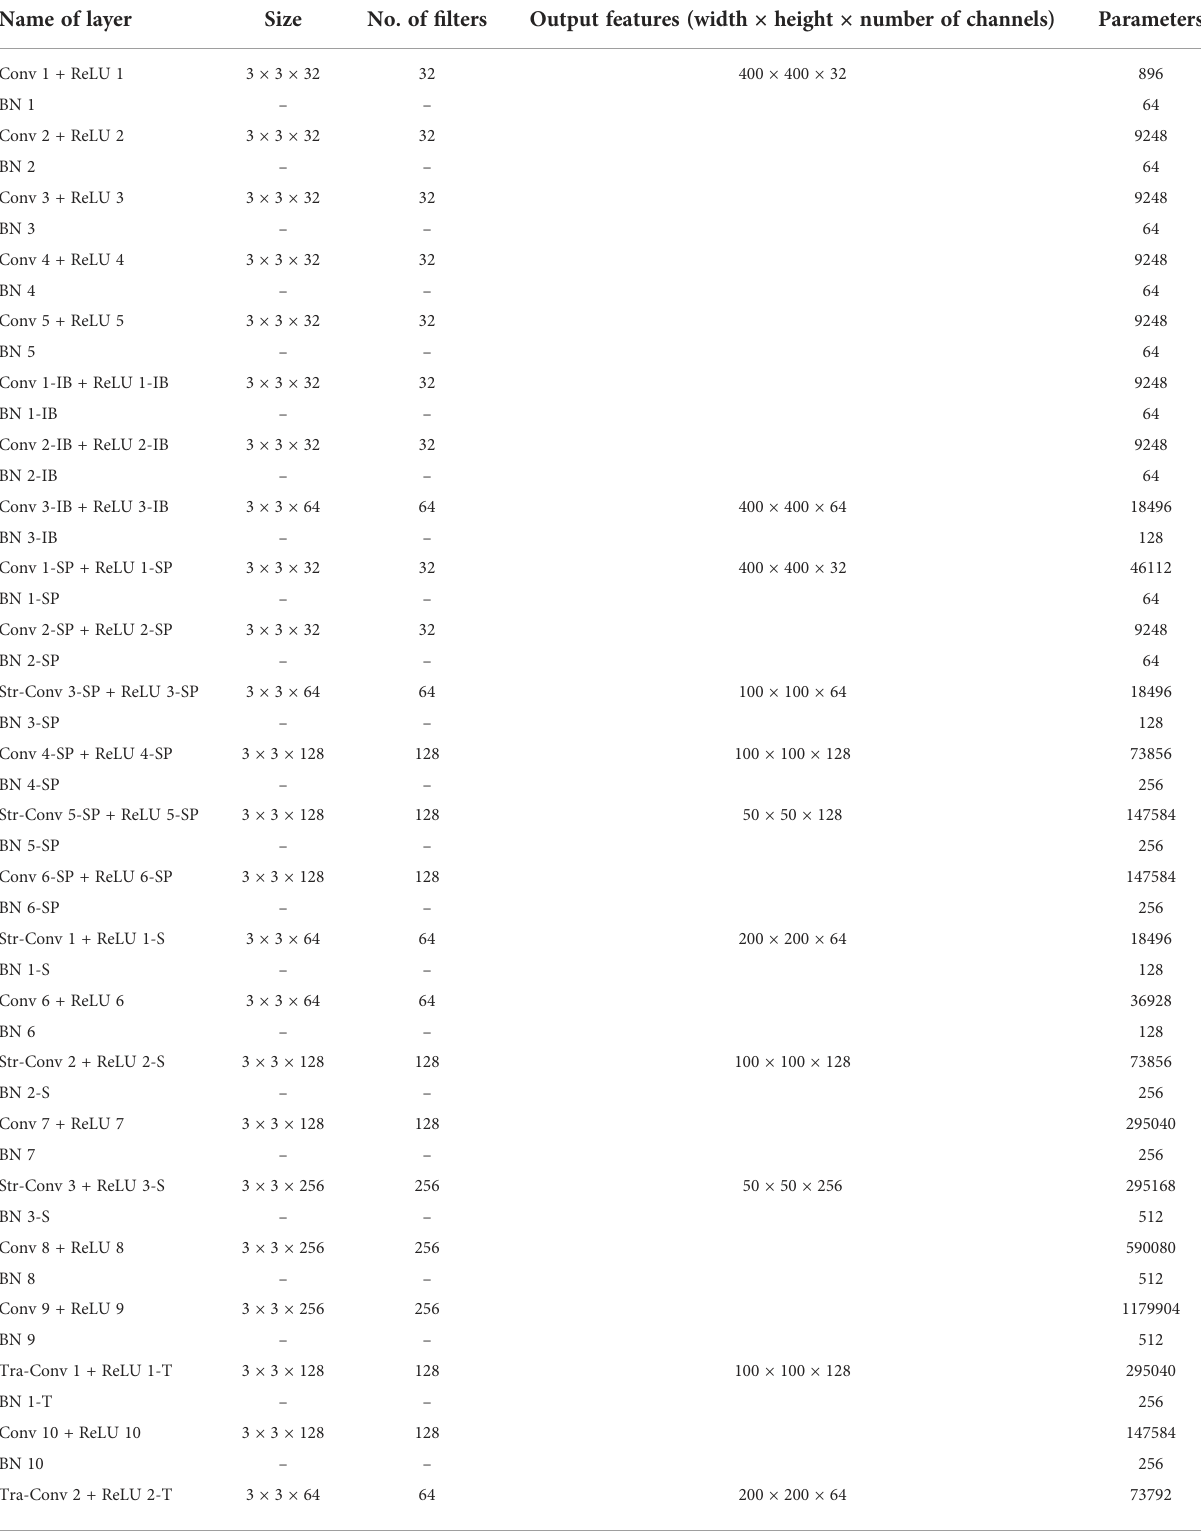
TABLE 1 Layers con fi gurational details of MFAS-Net with the number of required trainable parameters (Resized feature map of 400 × 400 is used to show the con fi guration of the layers) (Str-Conv, Strided convolution layer; Tra-Conv ,Transposed convolution layer; IB, IFRT-Block; SP, Skip path; Conv,